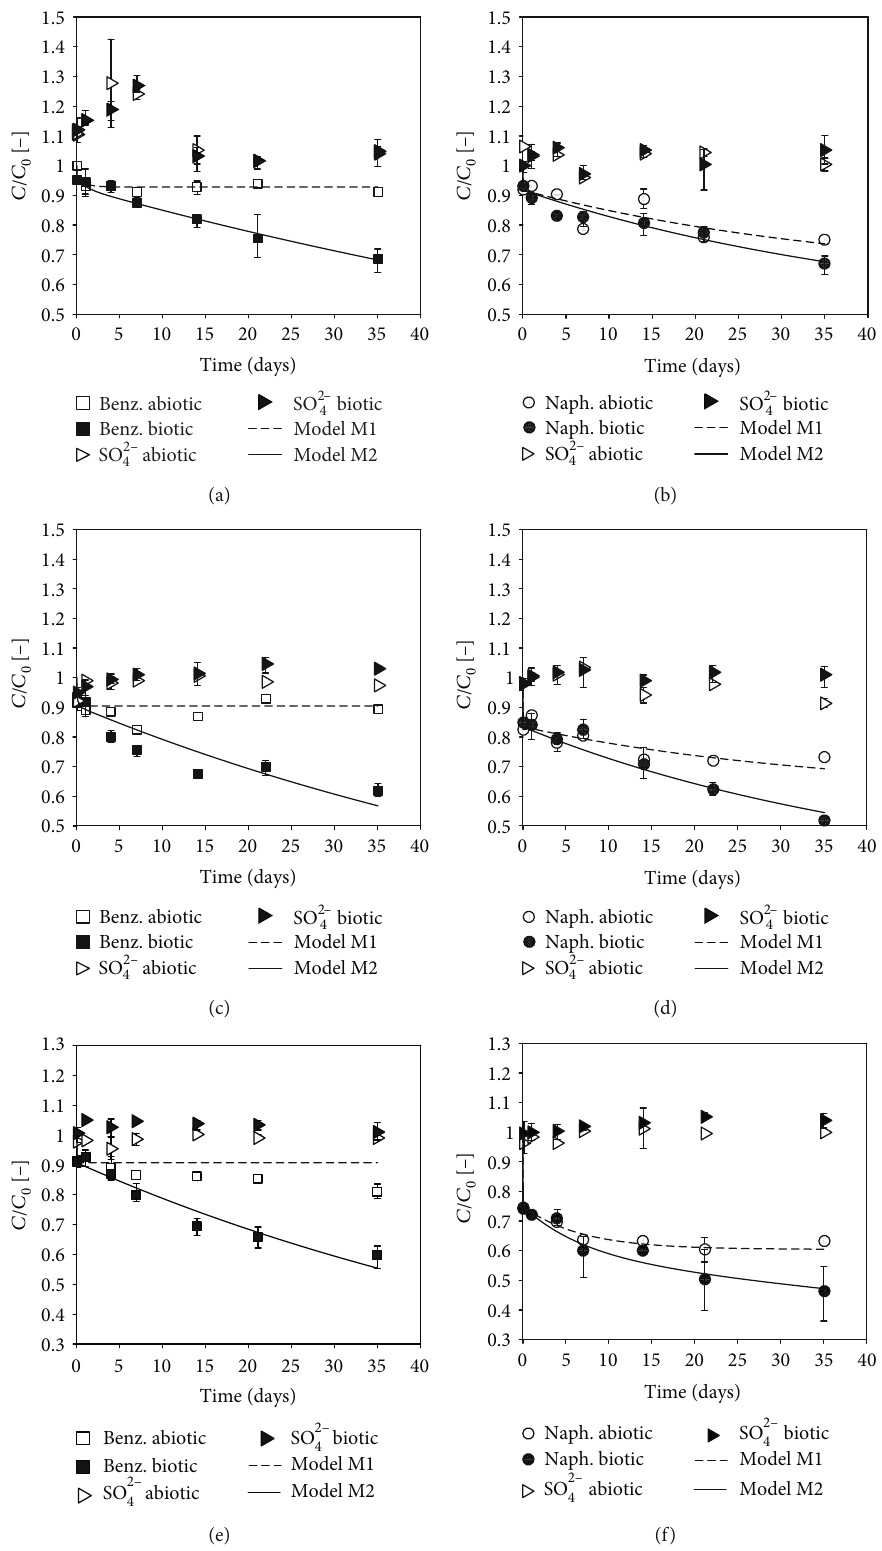
Figure 2: Sorption and biodegradation kinetics of benzene (Benz.) and naphthalene (Naph.) with soils A1 (a and b), A2 (c and d), and A3 (e and f) at low salinity. In Figures 2 – 4, the symbols are mean concentrations while the error bars are intervals between maxima and minima and they are within the width of the symbols when not visible. Aqueous concentrations at sampling time ( C ) are normalized by their respective initial concentrations ( C 0